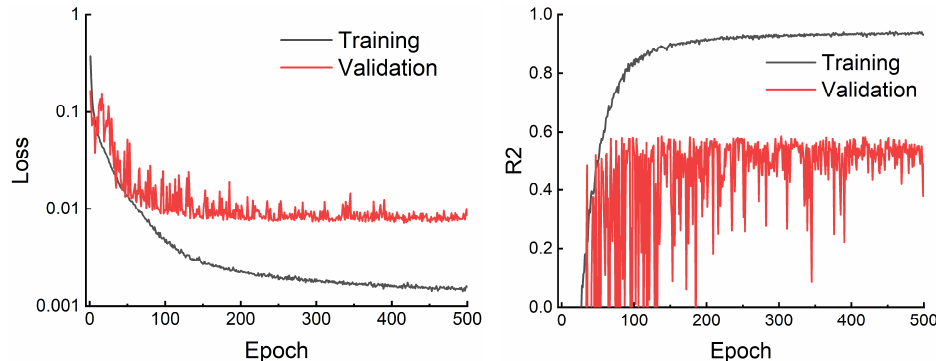
Figure 8. MSE and R 2 of the training and validation sets with plateau stress as the label.